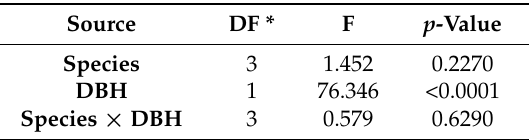
Table 7. Two-way ANOVA for combined data from units CR 1200 and CR 1003 showing degree of freedom, F statistics, and p -value for main effects (species and DBH), and their interaction with scar width (dependent variable).